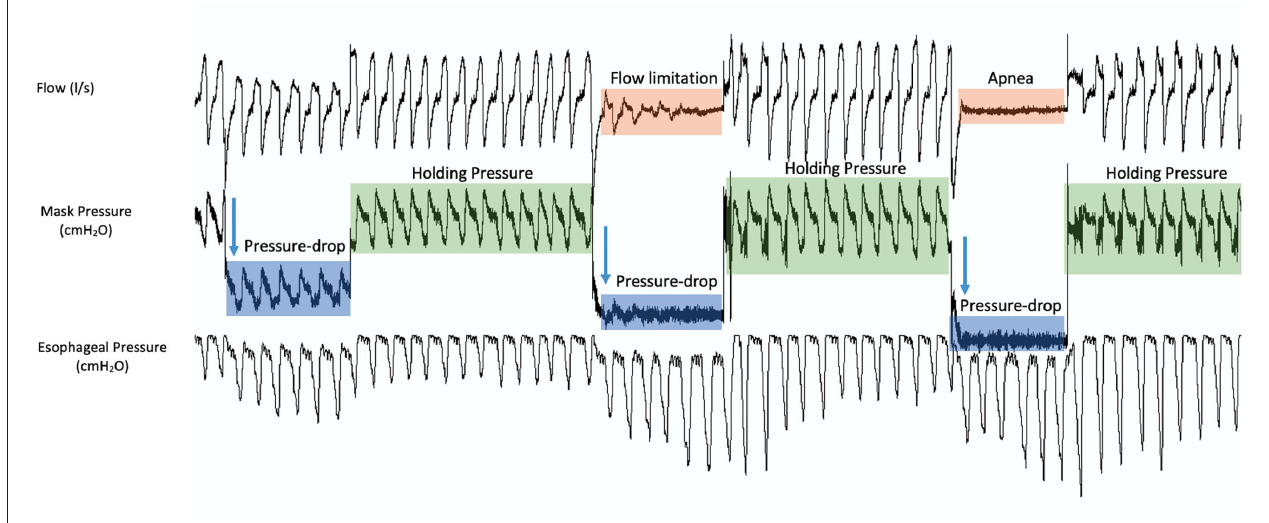
FIGURE 4 | A sample of 3 pressure drop series during the measurement of critical closing pressure (Pcrit). During measurements, the pressure is increased to a level where the pharyngeal airway is open and the airflow is not limited (holding pressure, green). Then, multiple series of pressure drops are performed. Starting at the holding pressure, the pressure is reduced to a lower pressure for a set number of breaths (blue), inducing flow limitation (orange), and then back to the holding pressure. This process is repeated until a pressure at which the airflow is zero (apnea, orange).